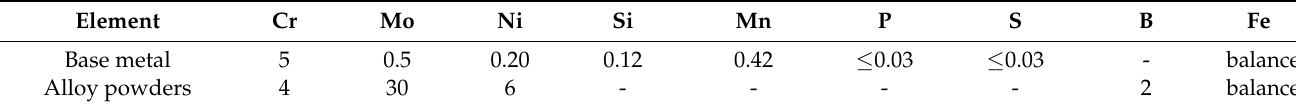
Table 1. Chemical compositions of the alloy powders/Cr5 steel